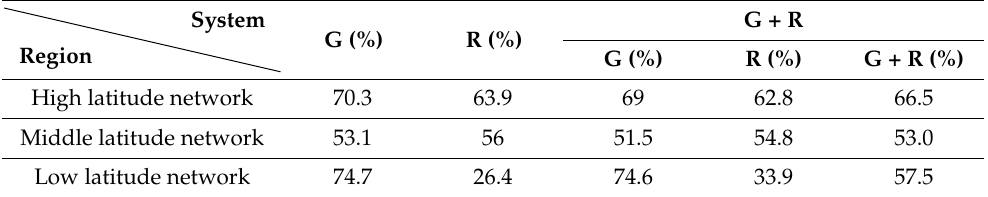
Table 7. The ambiguity fixing rate of DD processing (G, R, and G + R in black body denote the data processing mode, respectively. No bold G, R, and G + R represent the ambiguity fixing rate of GPS+GLONASS processing mode, respectively).